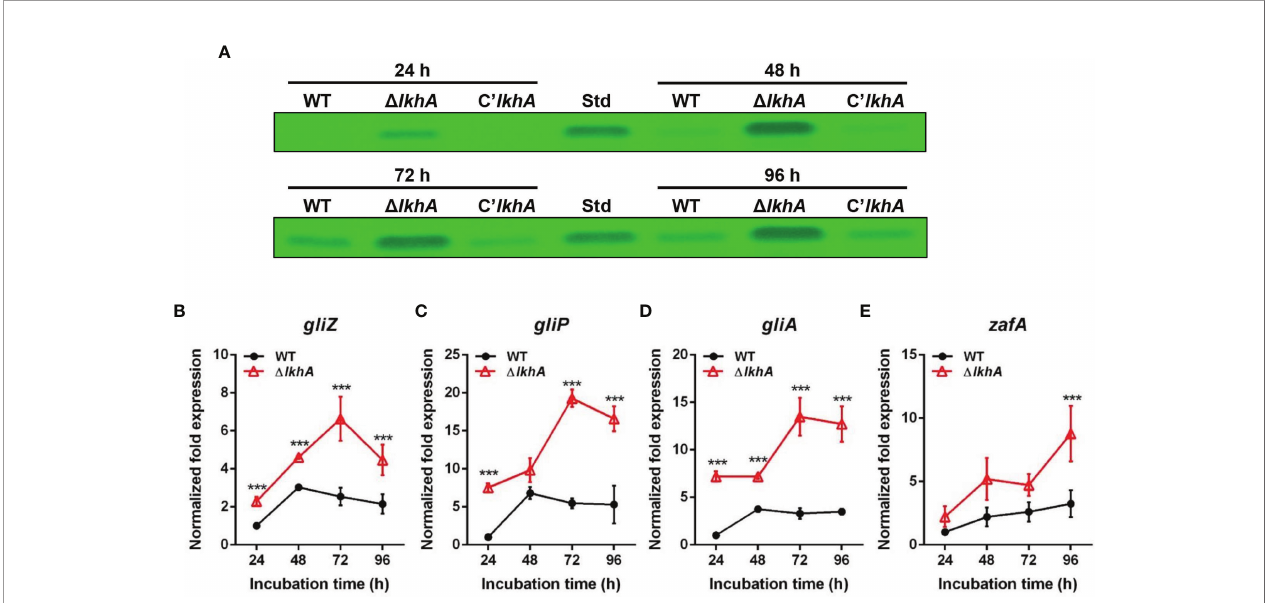
FIGURE 3 | Role of Af LkhA in gliotoxin production. (A) Determination of GT production in WT, D A fl khA , and C ’ A fl khA strains. GT were extracted with chloroform from culture supernatant of each strain and subjected to TLC. Std: GT standard (Simga-Aldrich). (B – E) Total RNA was extracted from mycelial balls incubated in Czapek Dox broth. RT-qPCR analysis was performed using 18S rRNA gene as an internal control. Expression patterns of GT cluster genes, transcription factor gliZ (B) , nonribosomal peptide synthetase gliP (C) , transporter gliA (D) , and transcriptional activator zafA (E) . ***P <